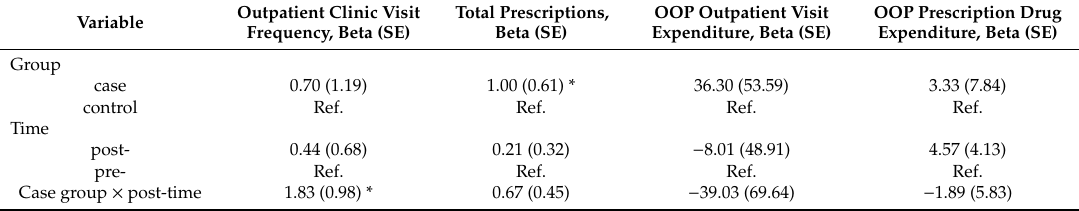
Table 3. Results of the di ff erence-in-di ff erences (DID) analysis 1 for outpatient clinic visit frequency, total prescriptions, OOP outpatient visit expenditure, and OOP prescription drug expenditure by group and